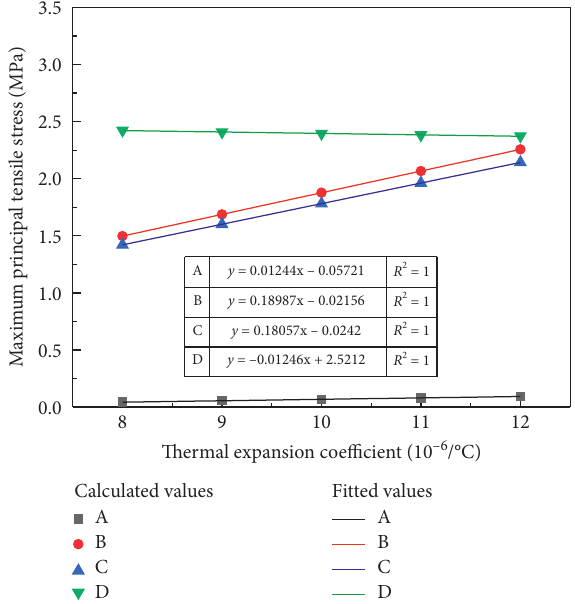
Figure 14: The calculated and fitted maximum principal tensile stress at each point with a different thermal expansion